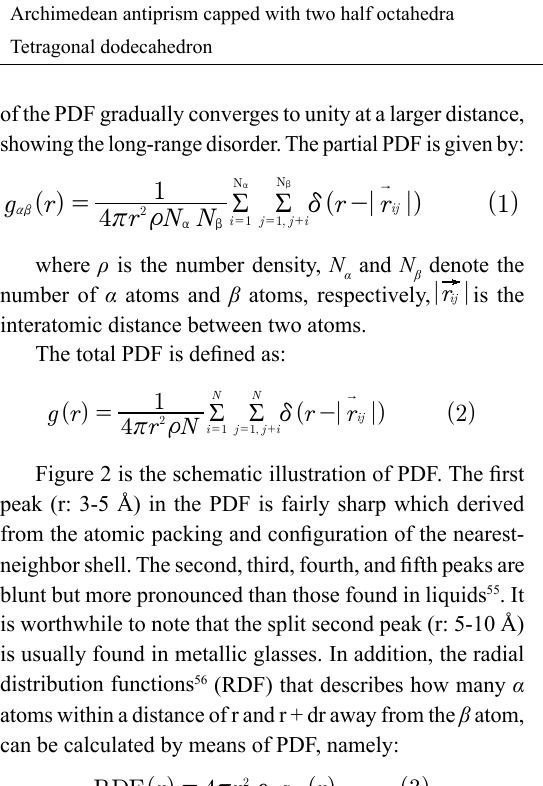
spheres are softened when considering the potential